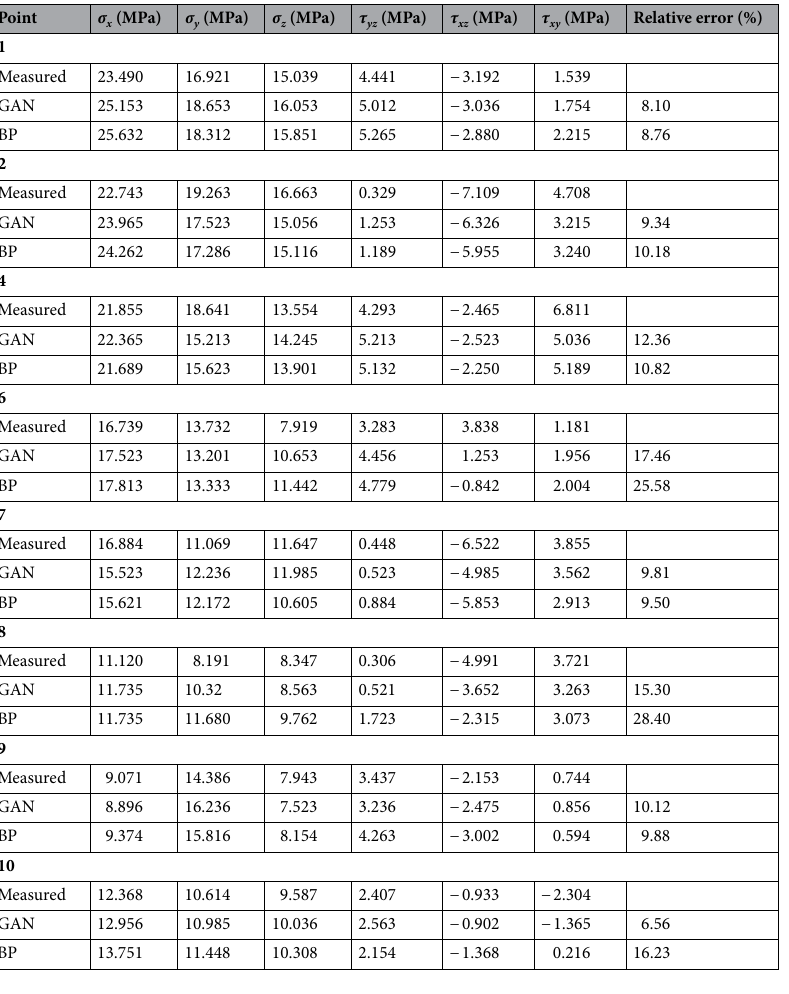
Table 7. Stress component values of each measured point based on GAN and BP neutral